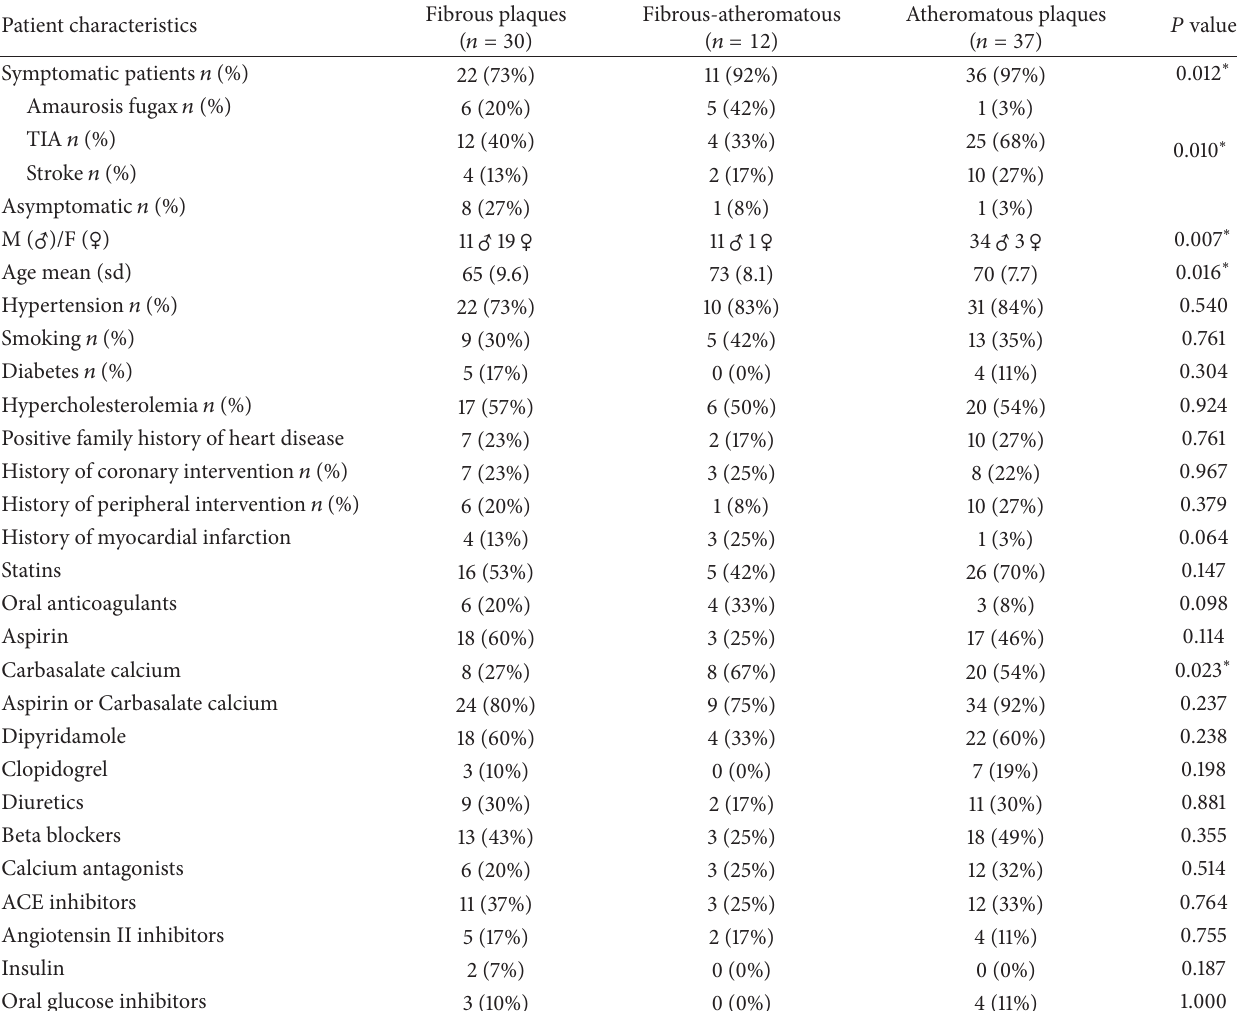
Table 4: Patient characteristics.